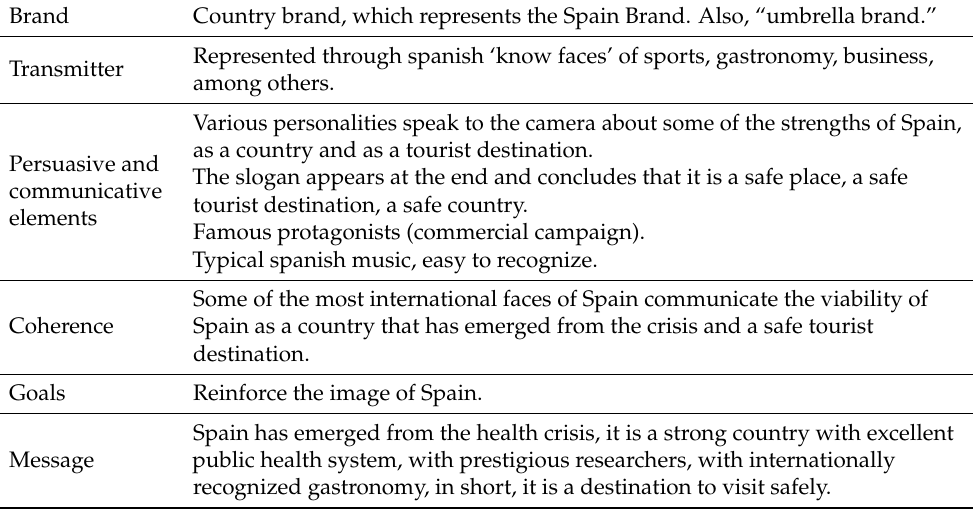
Table 6. Analysis of the campaign “Spain For Sure”. Brand Country brand, which represents the Spain Brand. Also, “umbrella brand.” Represented through spanish ‘know faces’ of sports, gastronomy, business, Transmitter among others. Various personalities speak to the camera about some of the strengths of Spain, as a country and as a tourist destination. Persuasive and The slogan appears at the end and concludes that it is a safe place, a safe communicative tourist destination, a safe country. elements Famous protagonists (commercial campaign). Typical spanish music, easy to recognize. Some of the most international faces of Spain communicate the viability of Coherence Spain as a country that has emerged from the crisis and a safe tourist destination. Goals Reinforce the image of Spain. Spain has emerged from the health crisis, it is a strong country with excellent Message public health system, with prestigious researchers, with internationally recognized gastronomy, in short, it is a destination to visit